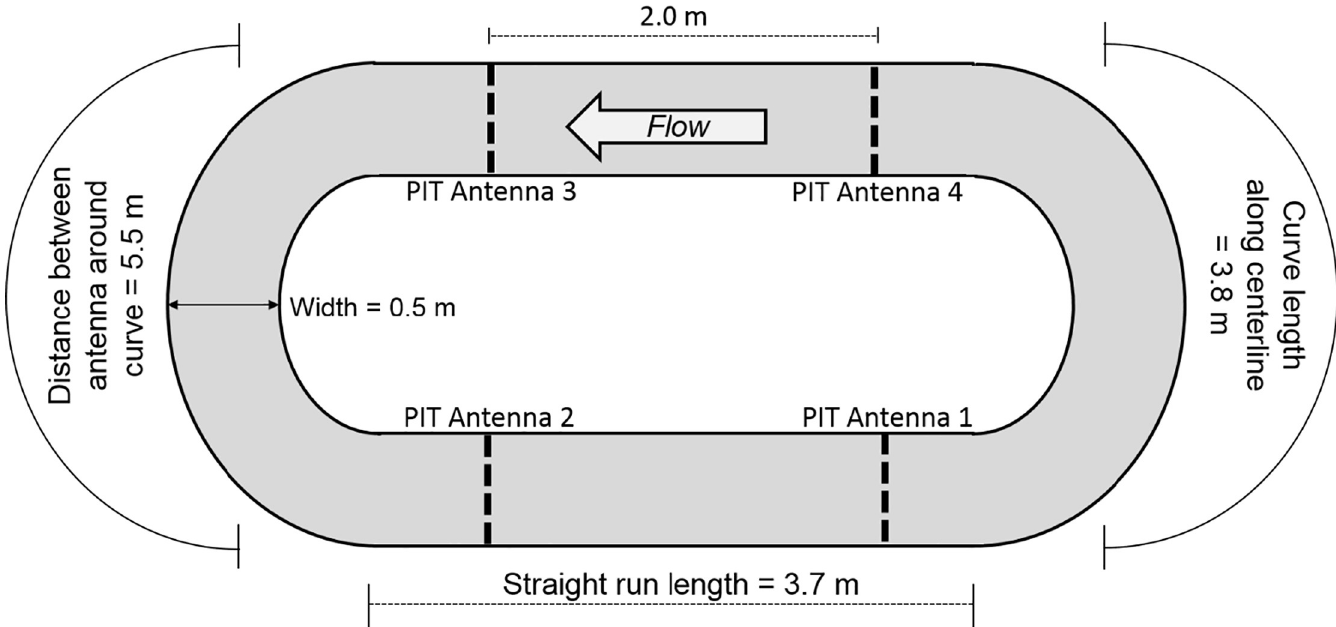
Fig 1. Study III artificial stream schematic. Upstream and downstream movement of newly-metamorphosed juvenile sea lamprey was monitored in a 15-m circumference artificial stream during November 6, 2014 –February 2, 2015.